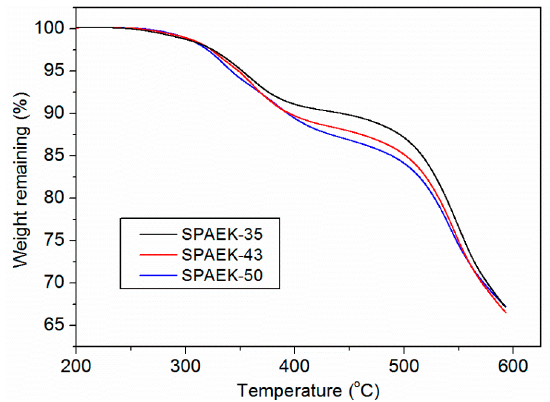
Figure 8. TGA curves of SPAEKs.